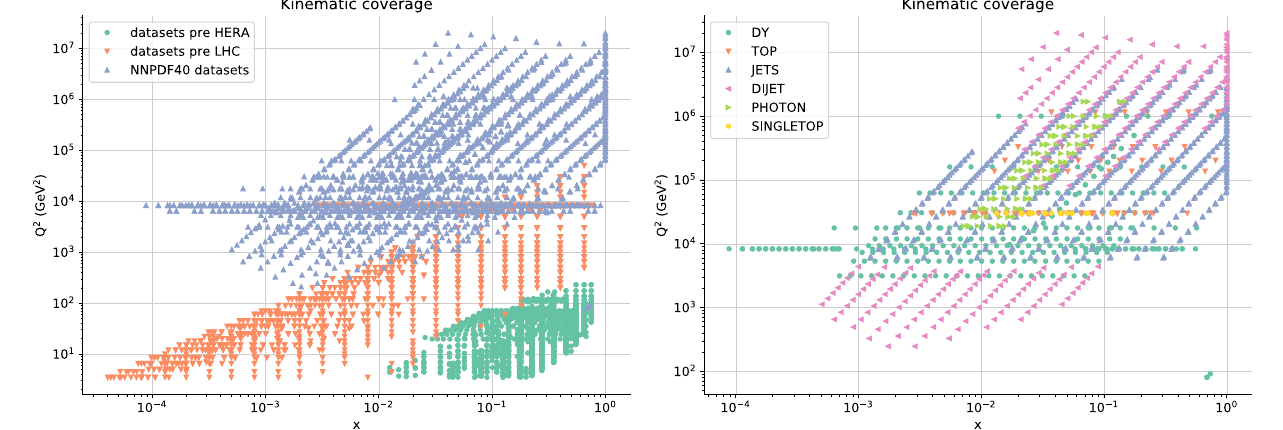
Fig. 27 Scatter plots comparing various future test data subsets to the full NNPDF4.0 of Fig. 2. Left: comparison of the pre-HERA, pre-LHC and NNPDF4.0 datasets. Note that each dataset is a superset of the pre- vious one, so all the pre-HERA data are included in the pre-LHC set,